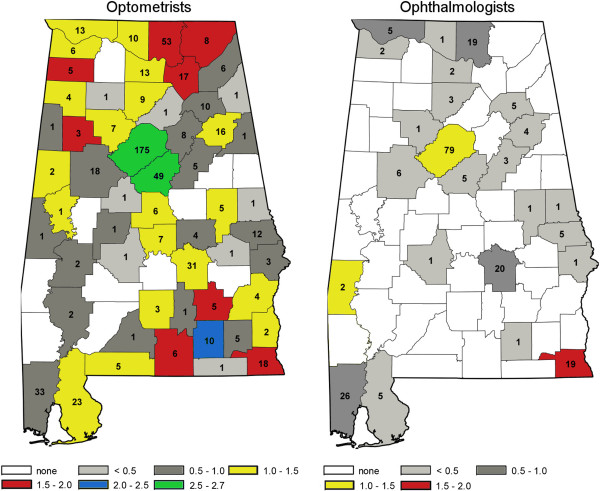
Alabama County of practice location, numbers of and per 10,000 population, optometrists and ophthalmologists.